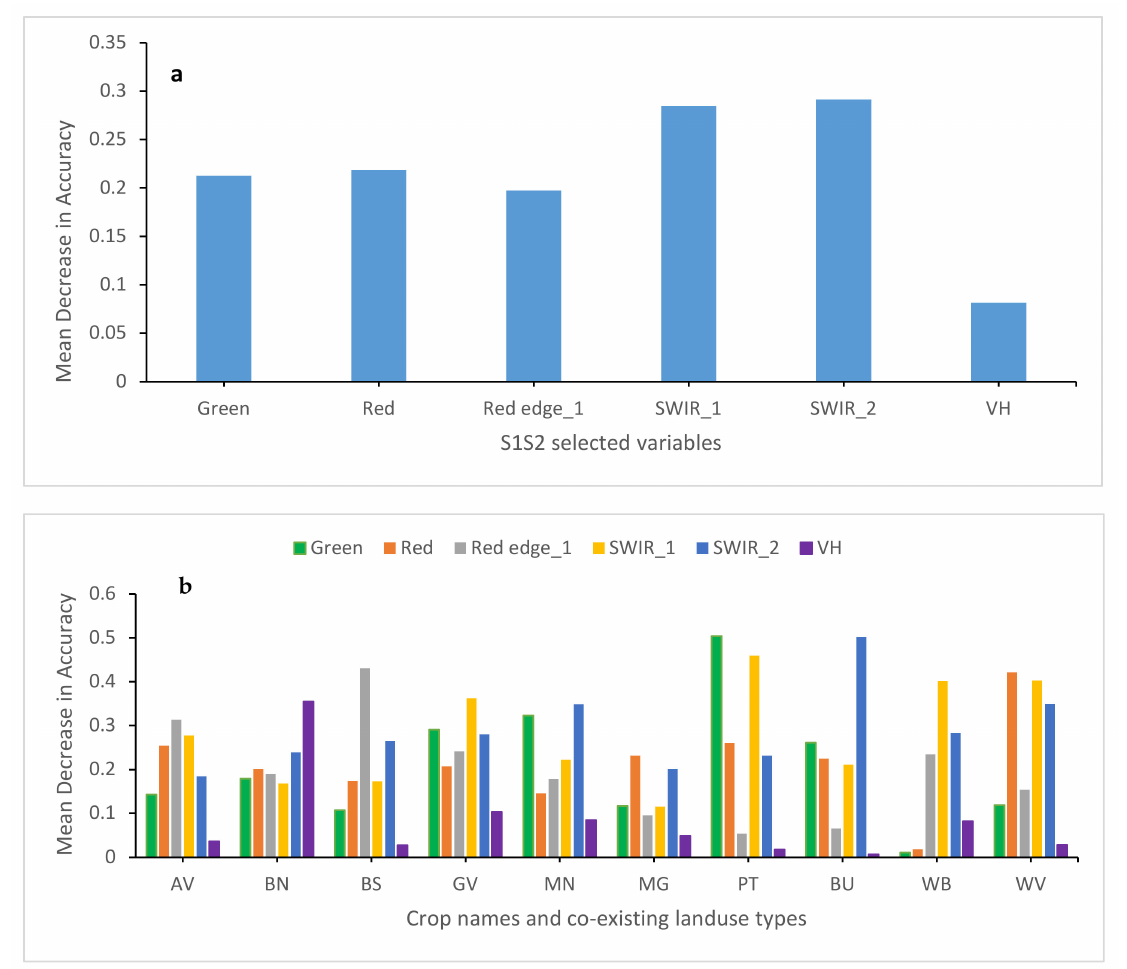
Figure 4. The variable importance in the RF classification model indicates the mean decrease accuracy (MDA) for ( a ) selected variable models. A high MDA importance indicates that the predictor variable plays a crucial role in the classification. ( b ) shows the mean decrease accuracy (MDA), indicating the relationship between S1S2 spectral bands and